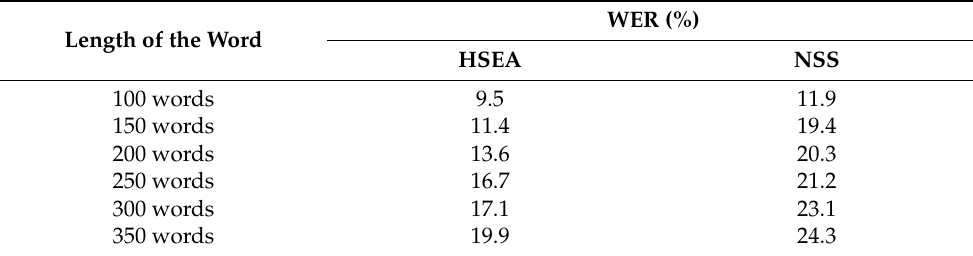
Table 6. WER, accuracy using the HSEA and